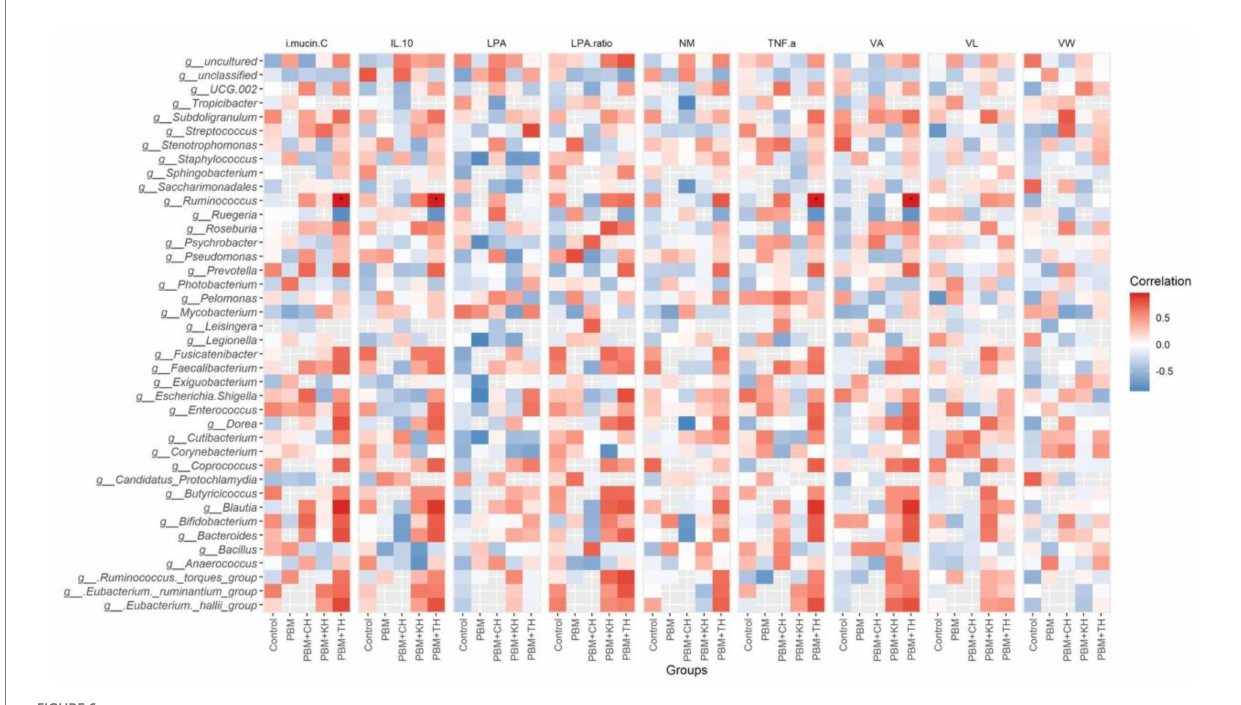
FIGURE 6 Pearson correlation plot of taxa-fish health indices. The top 40 bacterial genera were considered for correlation analysis with end-trial metadata for fish health and immunity. Red represents a positive correlation, whereas blue indicates a negative correlation. *Significant correlation at α -level of